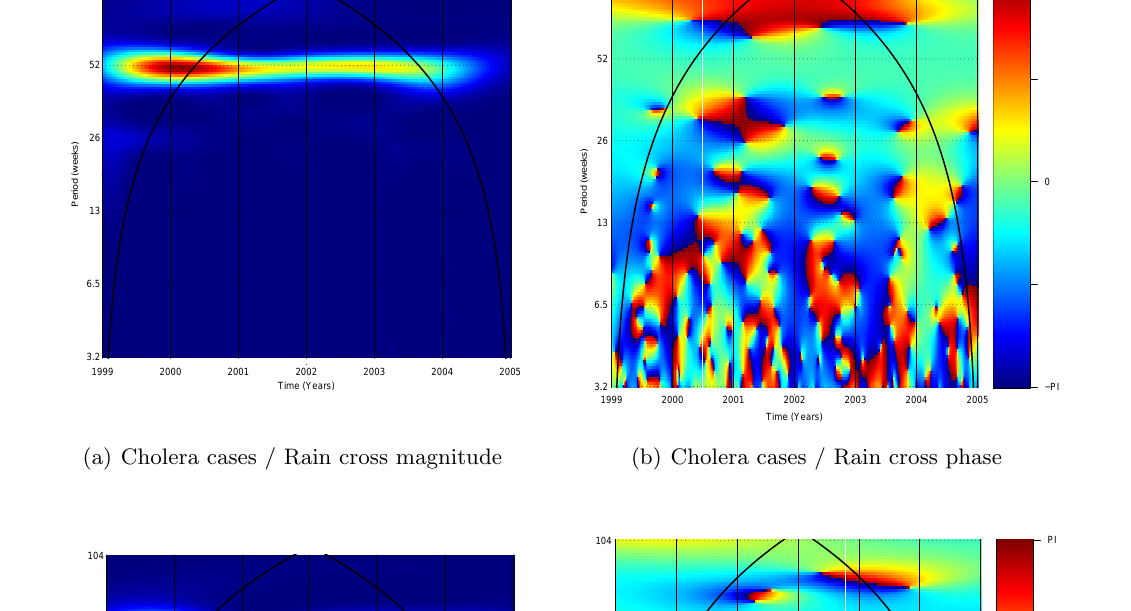
xy ( b, a ) | ) and phase ( arg [ W xy ( b, a )] ).